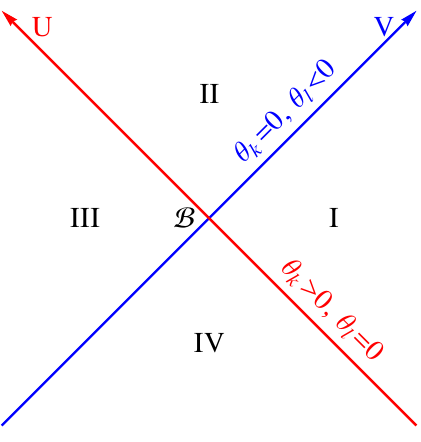
Figure 2 . The point B ( U = 0 ; V = 0), a ( D (cid:0) 2)-dimensional cross-section of the Horizon represents the Bifurcation surface, where (cid:18) k ; (cid:18) l =